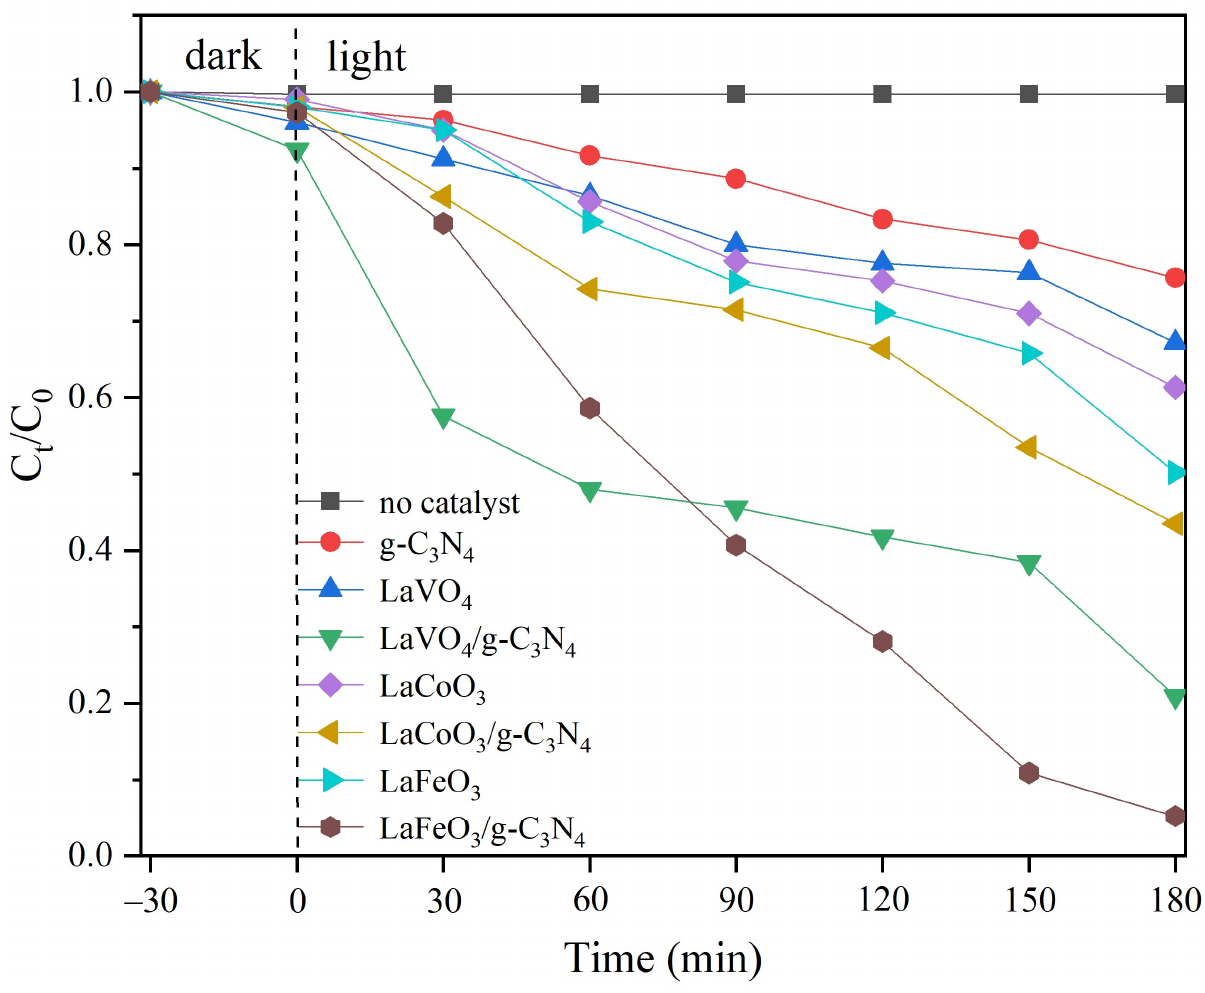
Figure 7. Photocatalytic performance of all